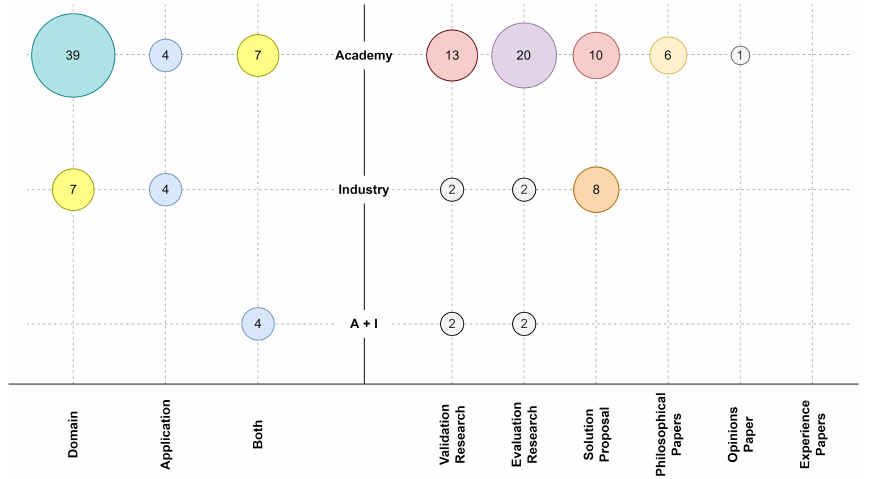
Figure 26. Summary of FM representation vs technologies implemented using reasoning algorithms.